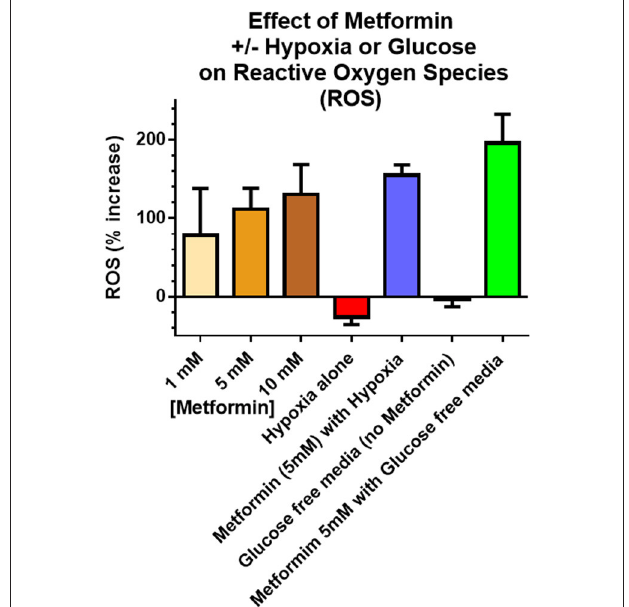
FIGURE 4 | Reactive Oxygen Species (ROS) were used as a surrogate measure of cell killing. Incubation times were 6h including metformin exposures, glucose concentration and hypoxia. in vitro ROS production increased with increasing metformin dose (4.5 g/L glucose), as well as combined hypoxia + metformin (4.5 g/L glucose). The largest increase in ROS occurred after combined glucose free media + metformin. Unless otherwise noted, metformin dose was 5mM. “Glucose free” indicates an absence of glucose in the media and “Hypoxia” refers to 6h of 5% CO 2 plus 95% N 2 exposure. Error bars represent standard deviations.